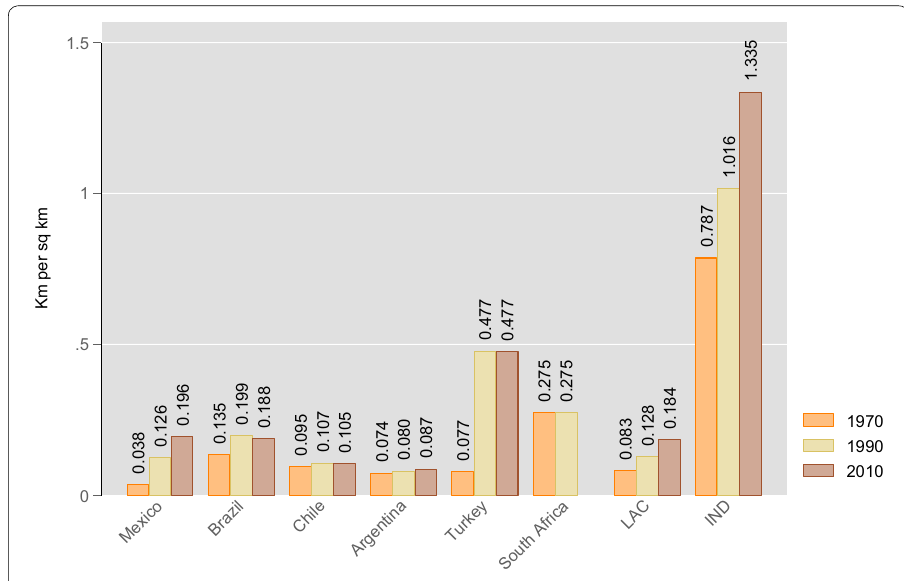
Fig. 3 Overview of transport infrastructure. Note LAC region (excludes Mexico, Brazil, Argentina and Chile) and IND report medians Source: IRF and author’s